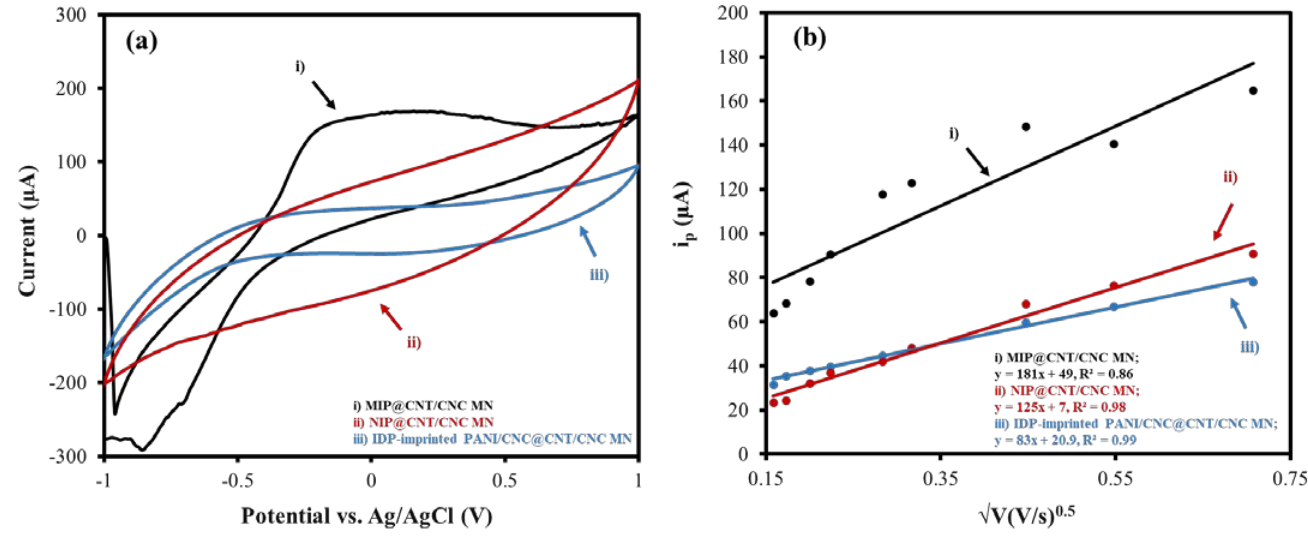
Figure 4. ( a ) Representative CV scans taken at 0.10 V/s and ( b ) associated peak cathodic current (i p ) as a function of the square root of the scan rate for (i) MIP@CNT/CNC, (ii) NIP@CNT/CNC, and (iii) Table 1. Electroactive surface area and electron transfer resistance (R ct ) values for MIP@CNT/CNC,